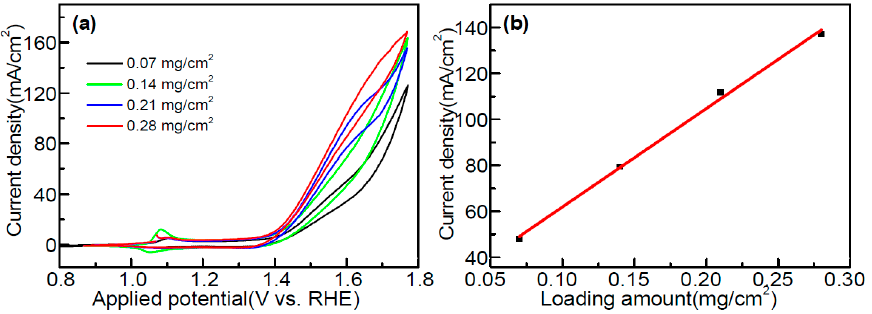
Figure 8. CVs of Co 3 (PO 4 ) 2 nanosphere-modified electrode at 50 mV/s ( a ) at various Co 3 (PO 4 ) 2 loadings, and ( b ) the plot of anodic methanol oxidation current density vs. the electrocatalyst loading amount at 1.65 V vs. RHE.